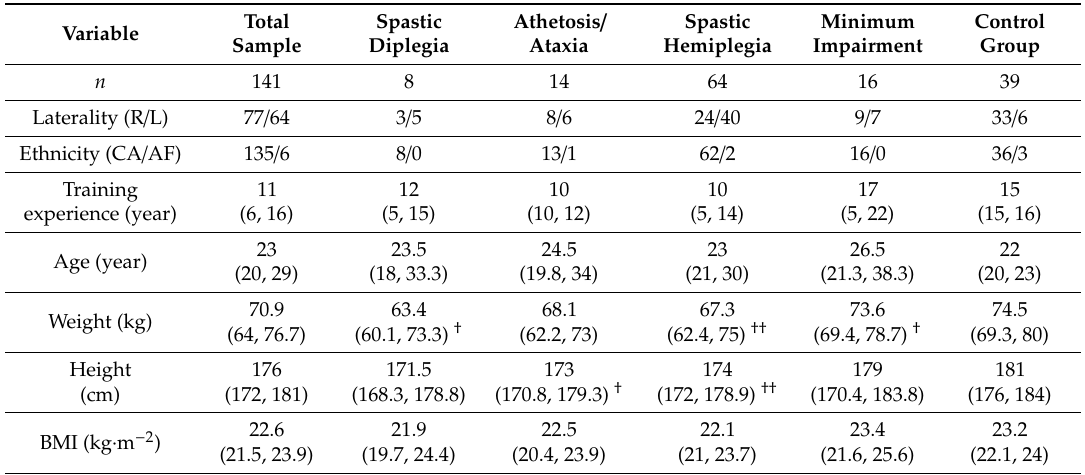
Table 1. Characteristics of the sample and general body